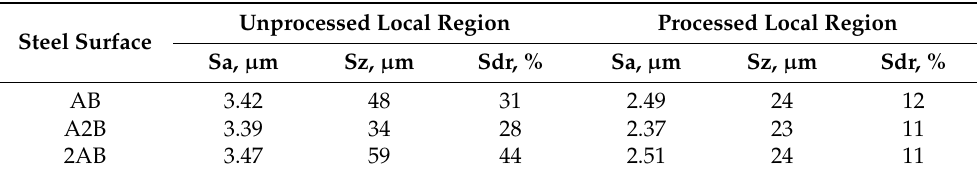
Table 2. The 3D roughness parameters of steel surfaces.